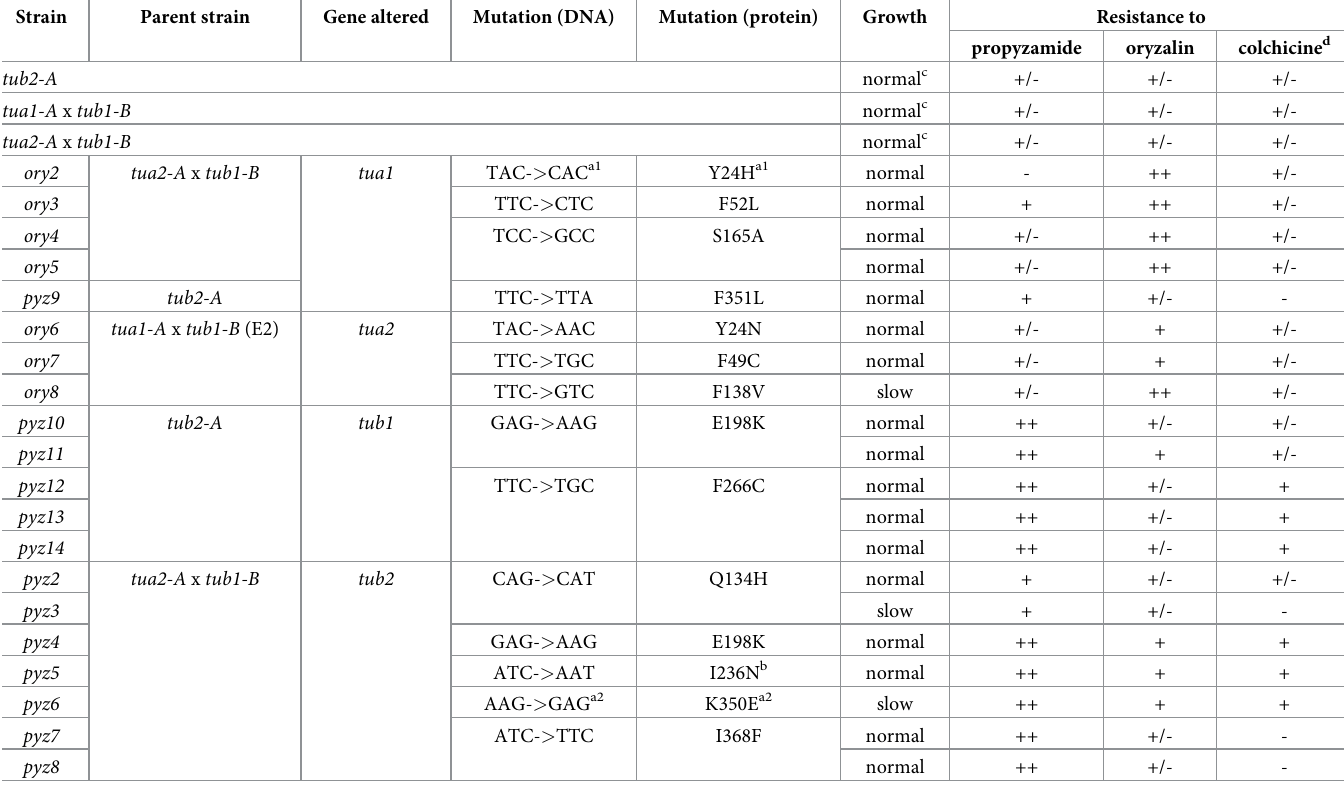
Table 1. Tubulin missense mutants isolated in this